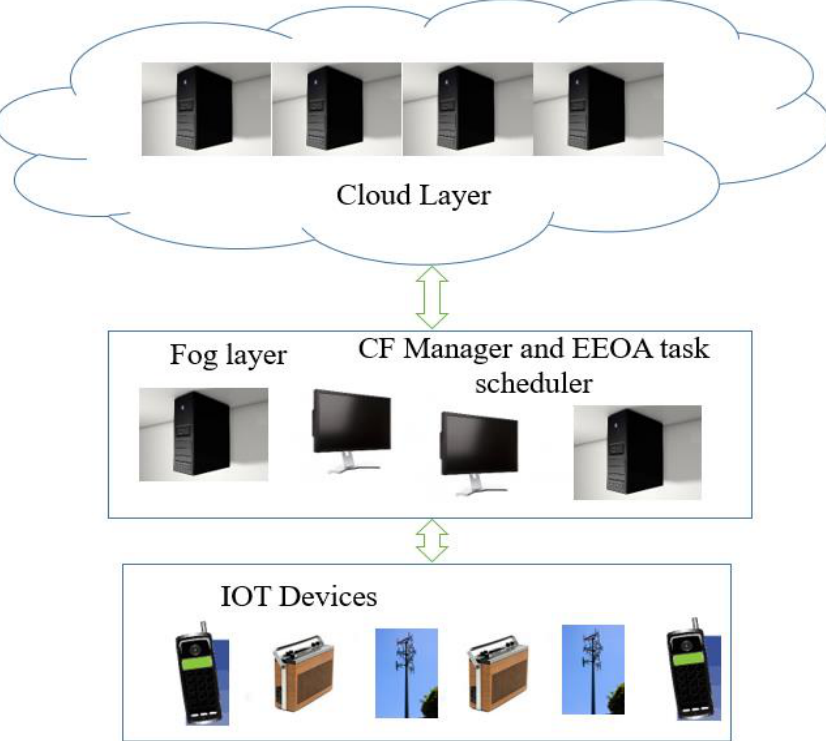
Figure 1. System